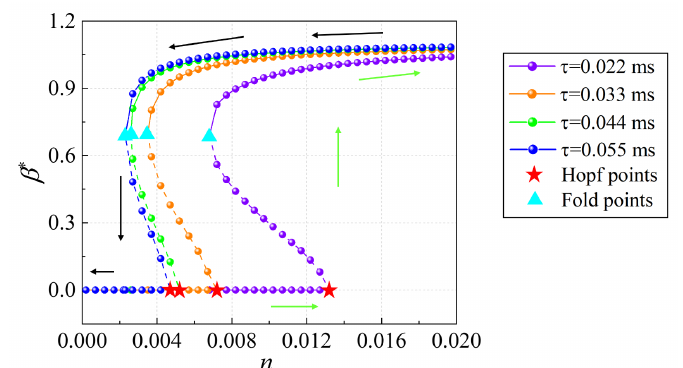
Figure 12. The bifurcation diagrams for the fifth order FDF. The green arrows represent the system developing direction when the gain n increases, the black arrows represent the system developing direction when the gain n decreases.